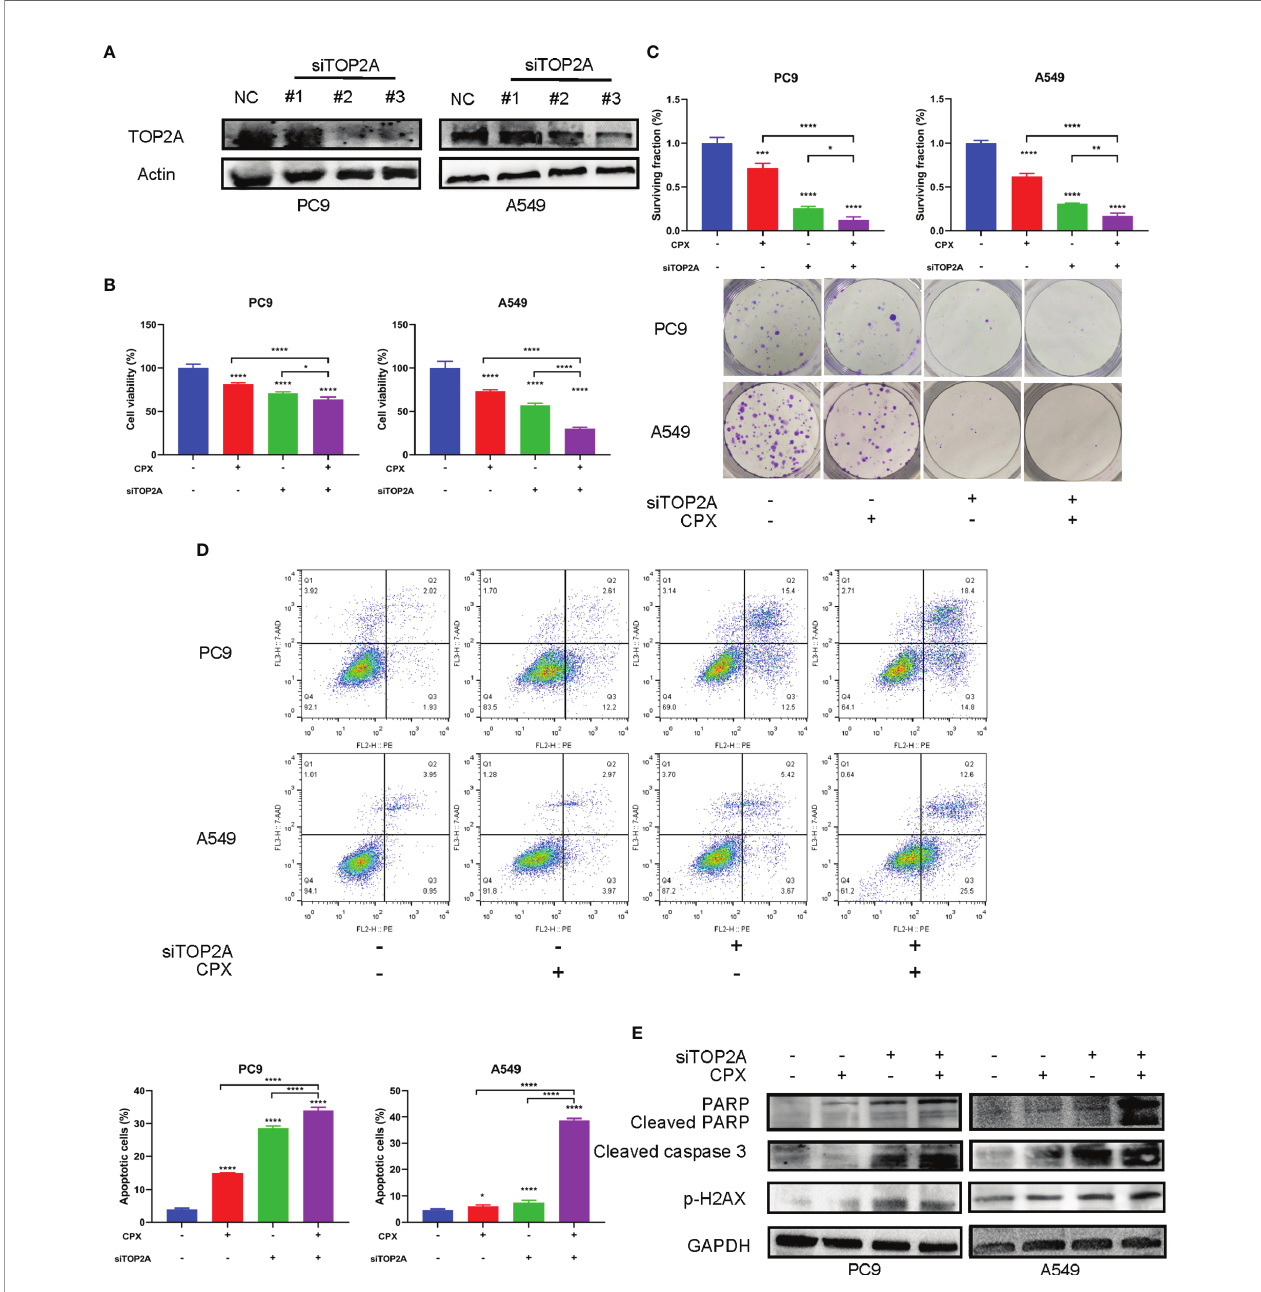
FIGURE 7 | TOP2A knockdown enhances CPX anti-tumor effects. (A) Western blot showing TOP2A expression at 48 hours post siRNA transfection. (B) Cells were transfected with TOP2A siRNA, 5 m M CPX, and combinations thereof; 24 hours later, cell viability was assessed using the MTT assay. (C) Cells were transfected with TOP2A siRNA, 5 m M CPX, and combinations thereof; 24 hours later, cells were seeded into 6-well plates for colony formation assays. (D) Cells treated with TOP2A siRNA, 5 m M CPX, and combinations thereof for 24 hours, fi xed, stained with PE/7-AAD, and analyzed by fl ow cytometry. (E) Western blotting showing PARP, cleaved PARP, cleaved caspase3, and p-H 2 AX expression in LUAD cells pretreated with TOP2A siRNA, 5 m M CPX, and the combination thereof for 48 hours. *P < 0.05; **P < 0.01; ****P < 0.0001. Statistical signi fi cance compared with respective control